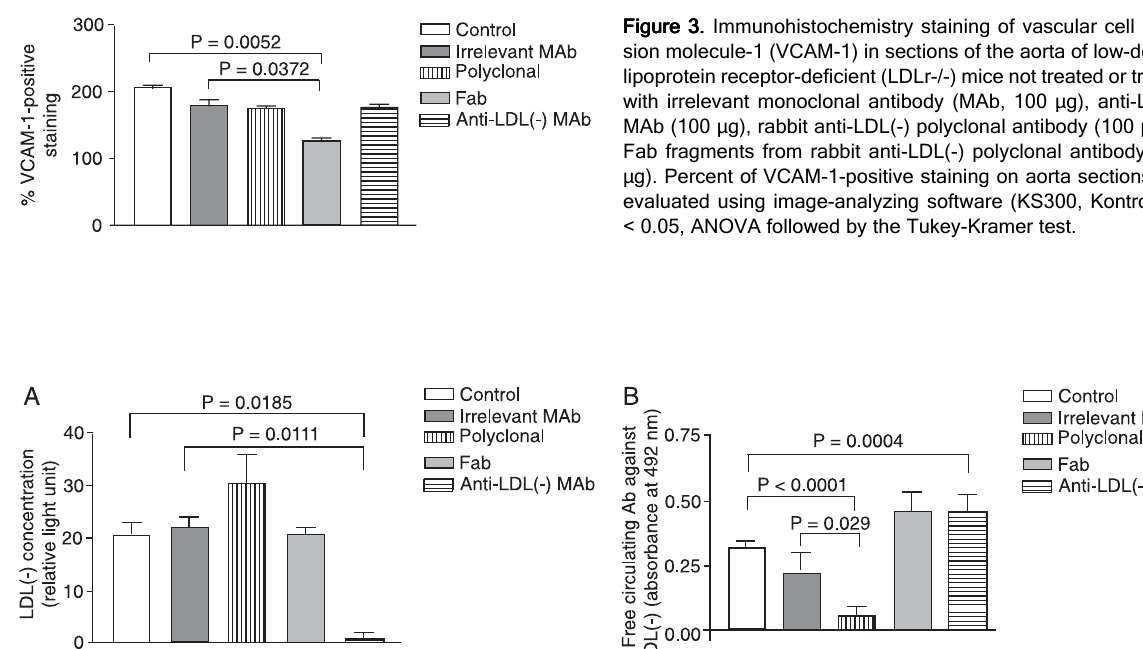
Figure 2. Atherosclerotic le- sions in aortic valve of low-den- sity lipoprotein receptor-defi- cient (LDLr-/-) mice. Aorta sec- tions of A, control mice; B, mice treated with anti-LDL(-) polyclo- nal antibody (100 µg); C, mice treated with Fab fragments from anti-LDL(-) polyclonal antibody (100 µg); D, mice treated with anti-LDL(-) monoclonal antibody (100 µg). The sections were stained with oil red O and the arrows indicate the build-up of plaque within the aorta. Magni- fication: 4X and 40X.